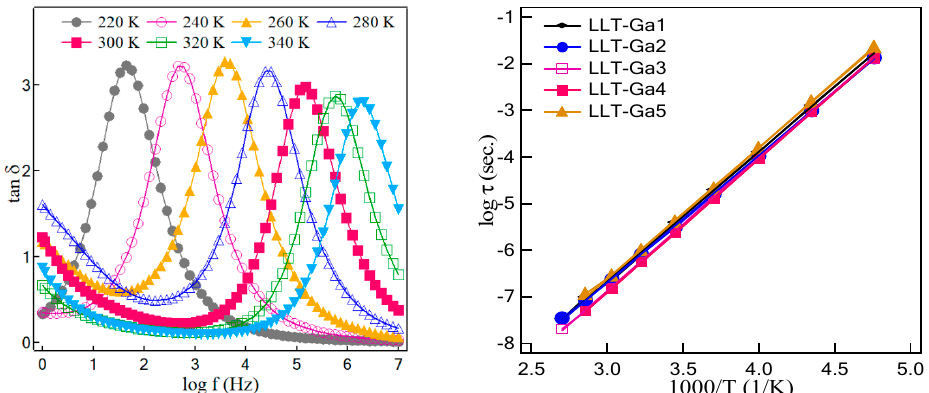
Figure 8. ( Left ) The frequency dependence of tan δ for LLT-Ga1 as a representative example, and ( right ) the temperature dependence of the dielectric relaxation time of Li 5+2x La 3 Ta 2-x Ga x O 12 garnets.